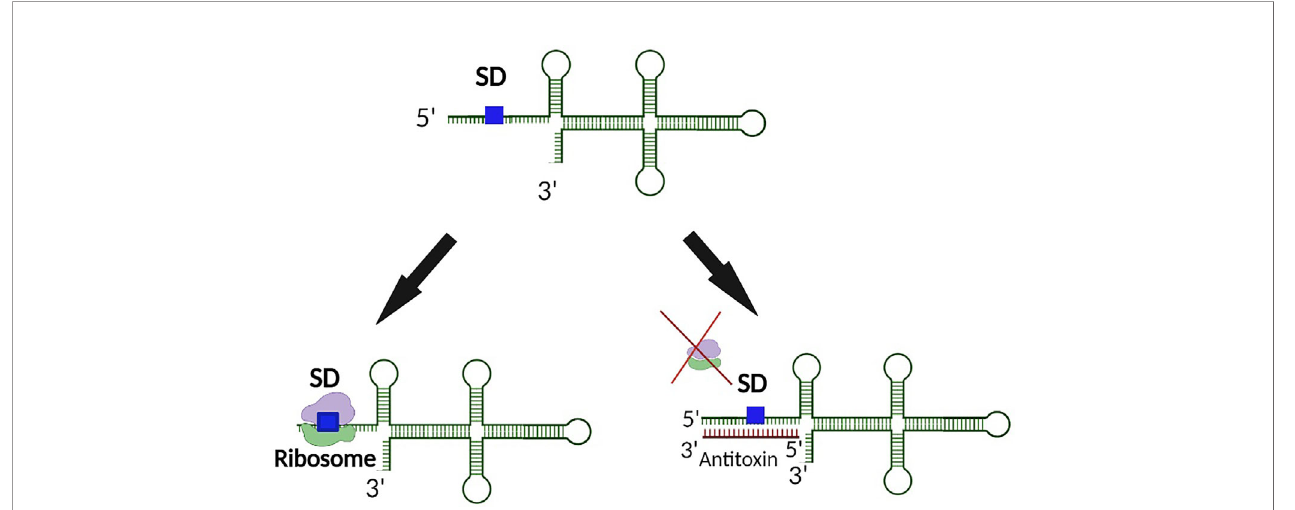
FIGURE 1 | Binding of a Type I antitoxin occludes the SD site on the toxin transcript. In a typical mechanism of regulation, the antitoxin of a Type I TA systems binds the target toxin transcript such that binding of the ribosome to the SD site is physically blocked. As such, translation of the Type I toxin is